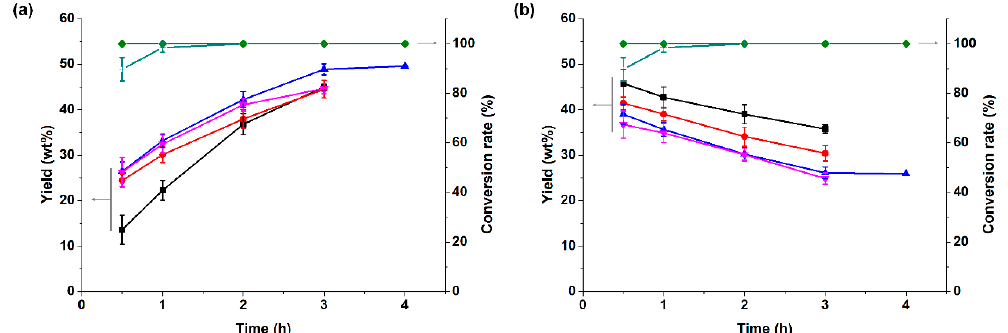
Figure 5. Effect of reaction time and temperature on the yields of ( a ) dimeric products and ( b ) camphene: ( ■ ) for 100 °C; ( ● ) for 110 °C; ( ▲ ) for 120 °C; ( ▼ ) for 130 °C; ( ◆ ) for α -pinene conversion 100 ◦ C condition; ( + ) for α -pinene conversion rate at 100 ◦ C condition. The used catalyst was prepared rate except for 100 °C condition; ( + ) for α -pinene conversion rate at 100 °C condition. The used catalyst by calcination at 550 ◦ C for 4 was prepared by calcination at 550 °C for 4 h.